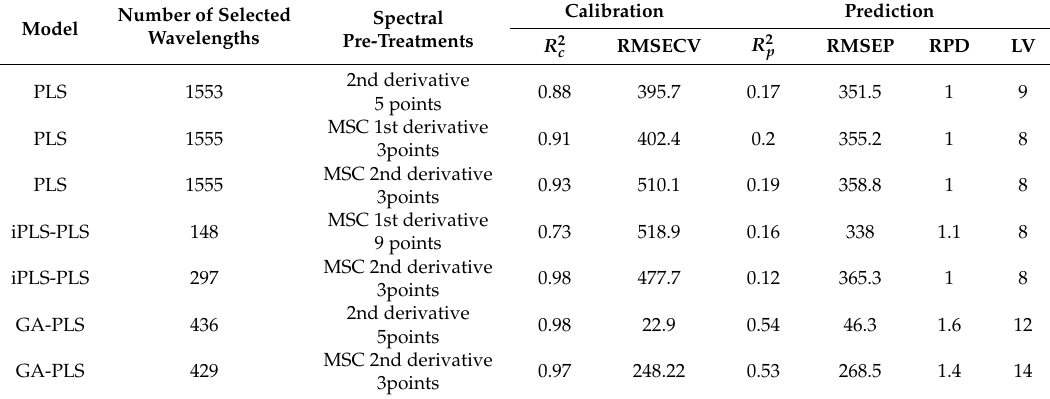
Table 2. Summary of statistics for the calibration and prediction sets for ascorbic acid (mg/100 g FW) in acerola fruit using FT-NIR z spectra and PLS, PLS-iPLS and GA-PLS. Number of Selected Spectral Model Wavelengths Pre-Treatments